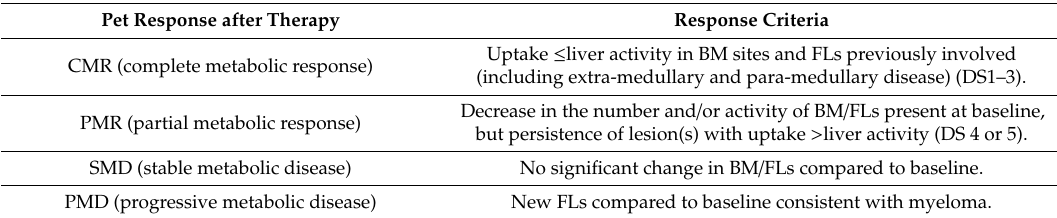
Table 1. Proposed refinement of the PET response criteria after therapy. Pet Response after Therapy Response Criteria CMR (complete metabolic